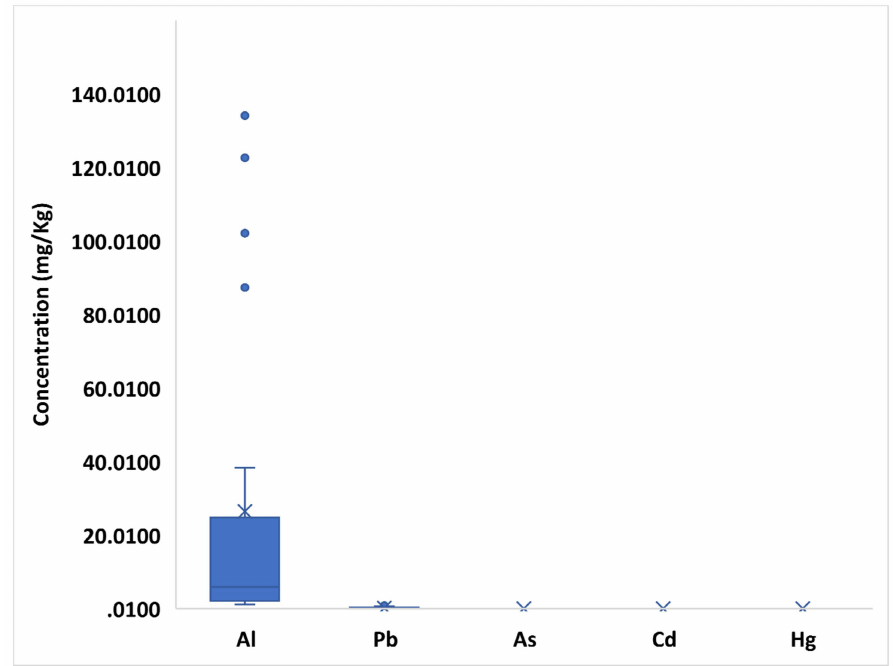
Figure 4. Box plot of potentially toxic element (Al, Pb, As, Cd, Hg) concentration in hemps. The “ × ” indicates the average value of each element, whereas the outlier points display the outlier data lying either below the lower whisker line or above the upper whisker